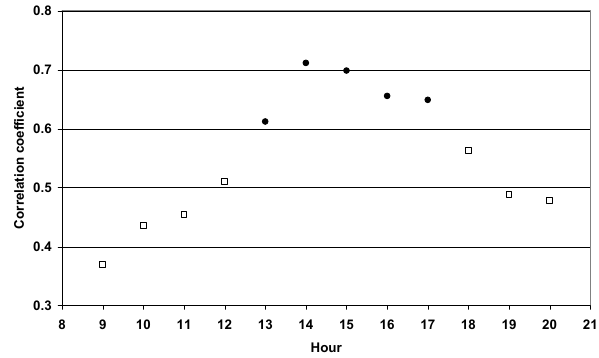
Fig. 3. Hourly evolution of the mean mixing heights at the sampling site in June and July 2004 for specific hours of the day. The bars show the uncertainty intervals of least significant differences at 95% confidence level.